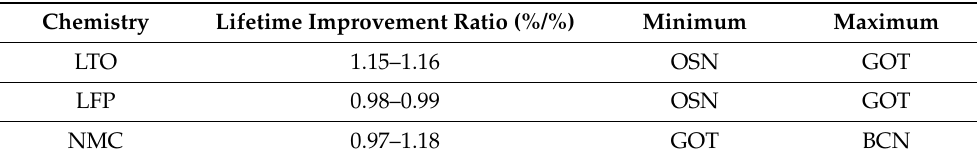
Table 12. Summary of results for the sensitivity to the battery